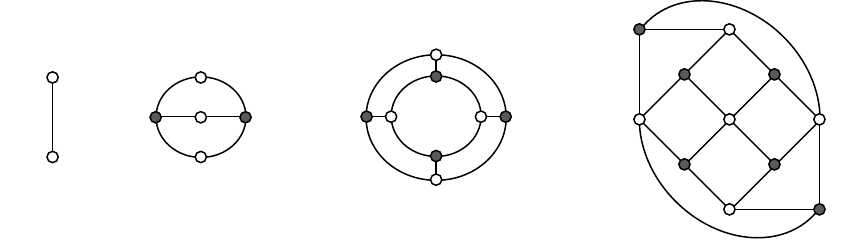
Figure 26 . Examples of the planar bipartite graphs for n = 2 ; 3 ; 4 ; 5.